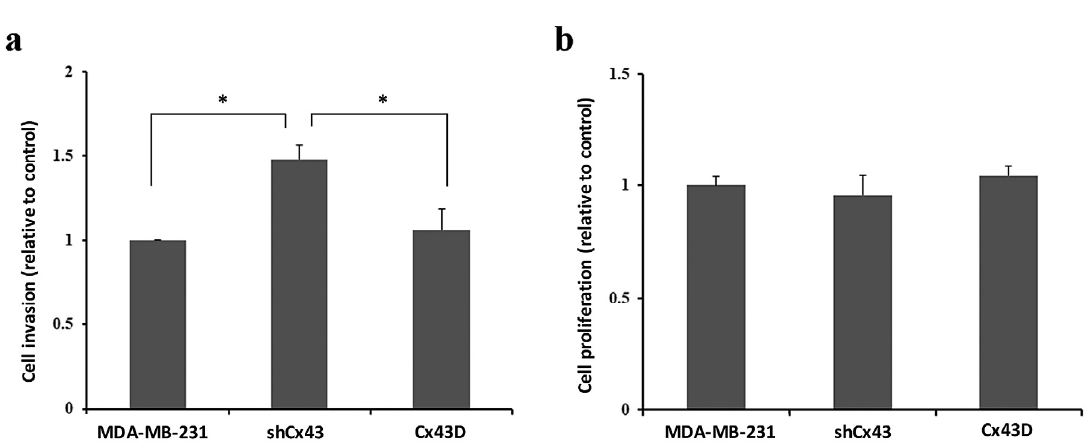
Figure 4. Cx43 knock-down enhances the invasion of MDA-MB-231 cells. ( a , b ). Bar graph showing the normalized cell index of shCx43 and Cx43D cells, relative to parental MDA-MB-231 cells, as detected by RTCA invasion and proliferation assays, respectively. Cell impedance readings were taken every 15min for a minimum of 48h. Results are representative of four independent experiments. * p < 0.05.